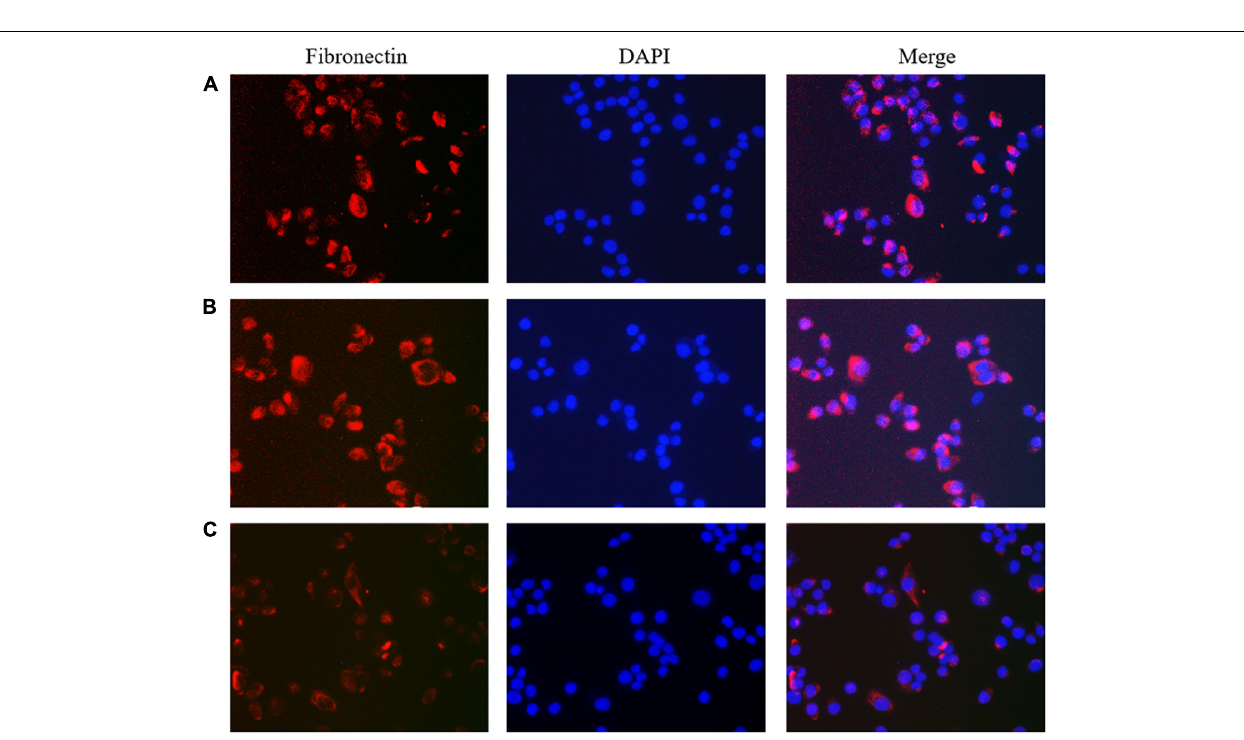
FIGURE 4 | The effect of lncRNA TPA overexpression and knockdown on the expression of MCF-7 Fibronectin antibody [200 × , (A) Normal breast cancer cells, (B) lncRNA TPA overexpression cells, (C) lncRNA TPA knockdown cells].